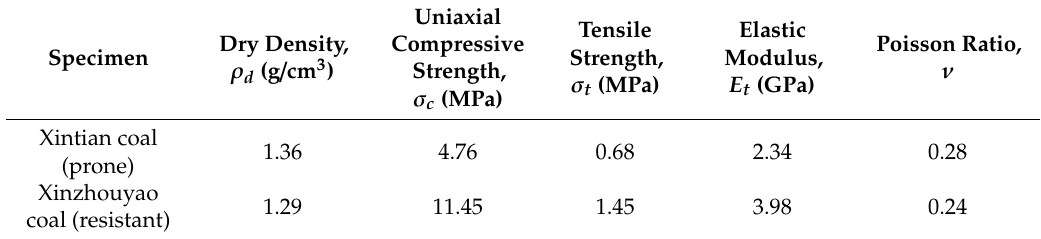
Table 1. Physical and quasi-static mechanical properties of coal specimens.